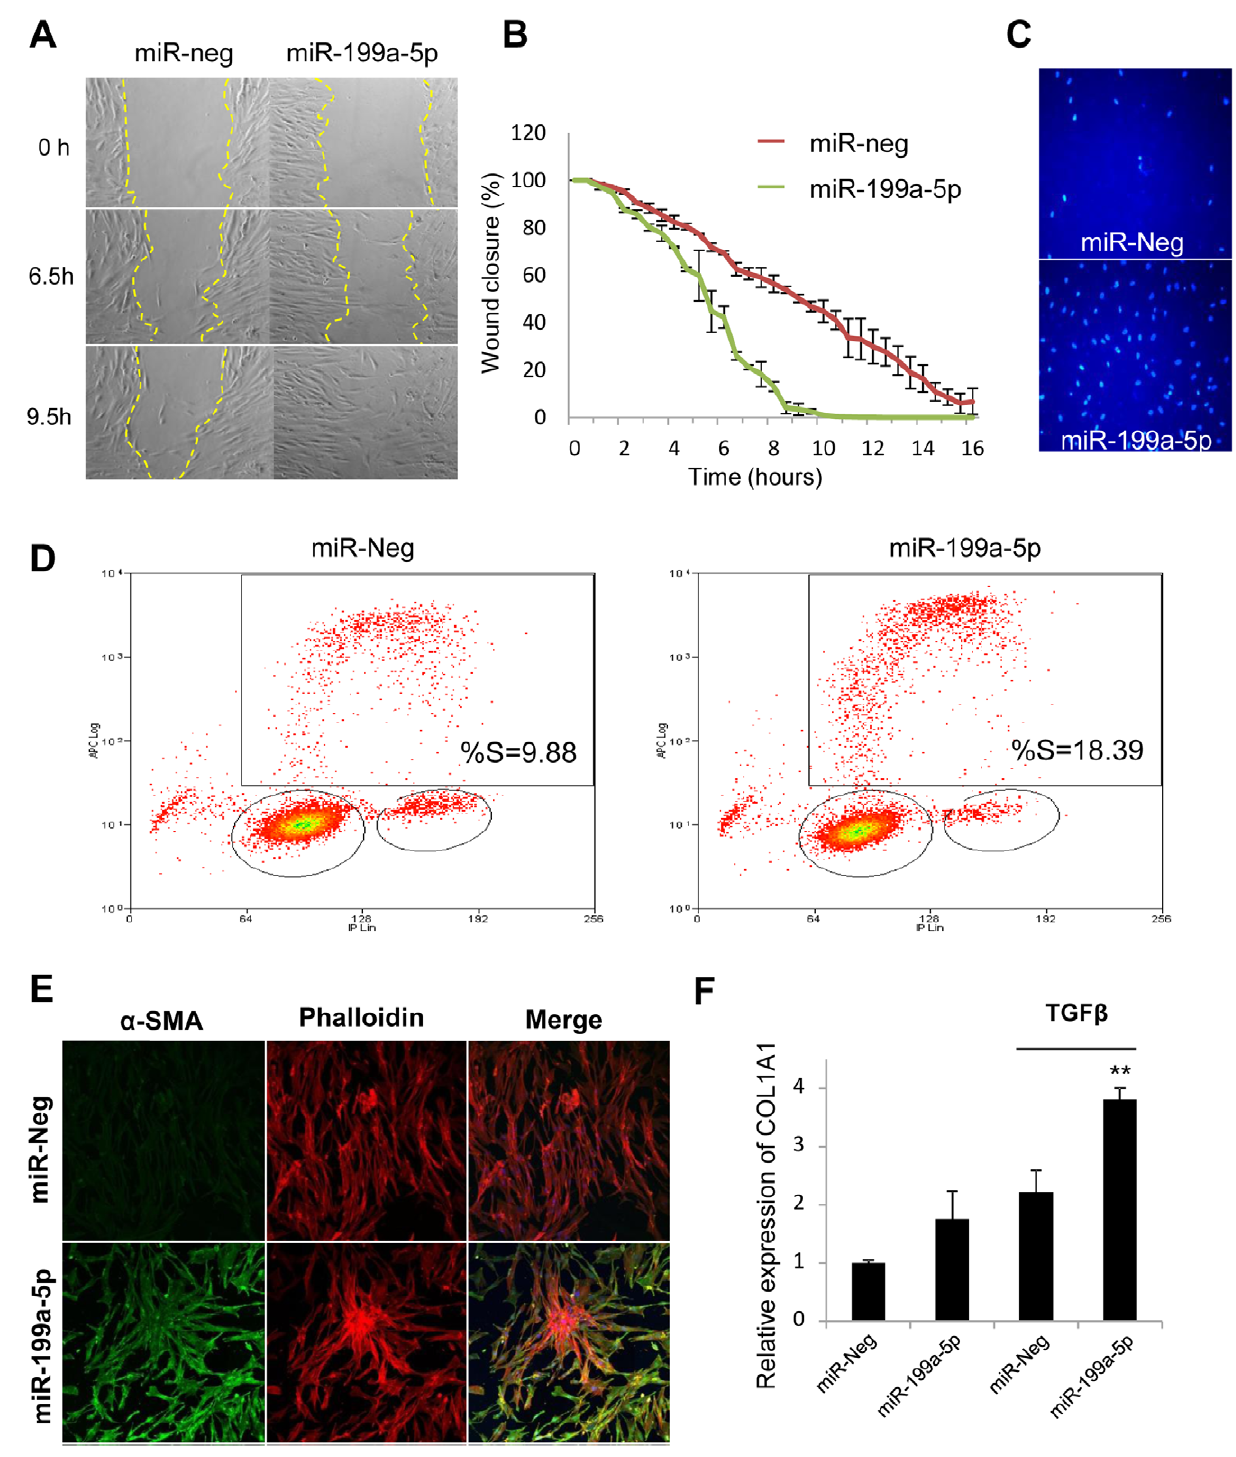
Figure 7. Functional impact of miR-199a-5p on lung fibroblasts. Increased expression of miR-199a-5p in lung fibroblasts results in an enhanced ability of fibroblasts to migrate, invade matrigel, proliferate and differentiate into myofibroblasts. Lung fibroblasts were transfected with 10 nM of miR-199a-5p mimic or control. (A,B) In vitro scratch assay was performed to assess the rate of migration of A significant increase (p , 0.01) in the migration rate was observed in miR-199a-5p transfected hFL1 lung fibroblasts compared with control. Data are representative of two independent experiments. (C) Invasion assay on matrigel showing that overexpression of miR-199a-5p increases MRC5 lung fibroblast invasiveness.. Data are representative of two independent experiments. (D) Proliferation assay was performed by bivariate flow cytometric analysis of EdU/DNA- stained MRC5 cells. The x-axis represents the linear intensity obtained from propidium iodide (total DNA content), and the y-axis represents the logarithmic intensity obtained from the Alexa Fluor 647. Cells are separated into G0/G1 phase and G2/M phase according to their DNA content, and into labeled undivided and labeled divided subgroups according to the DNA content of EdU-labeled cells. The % of cells in S phase is indicated on the